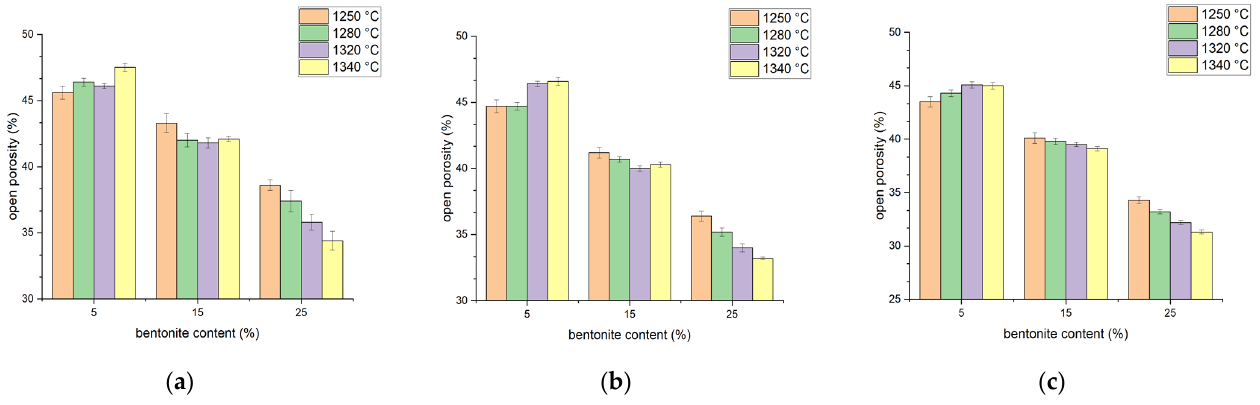
Figure 3. Content of bentonite binder vs. open porosity of ceramics based on electrocorundum F240 pressed at ( a ) 20; ( b ) 30; and ( c ) 40 MPa. Sintering temperature is indicated in a legend.